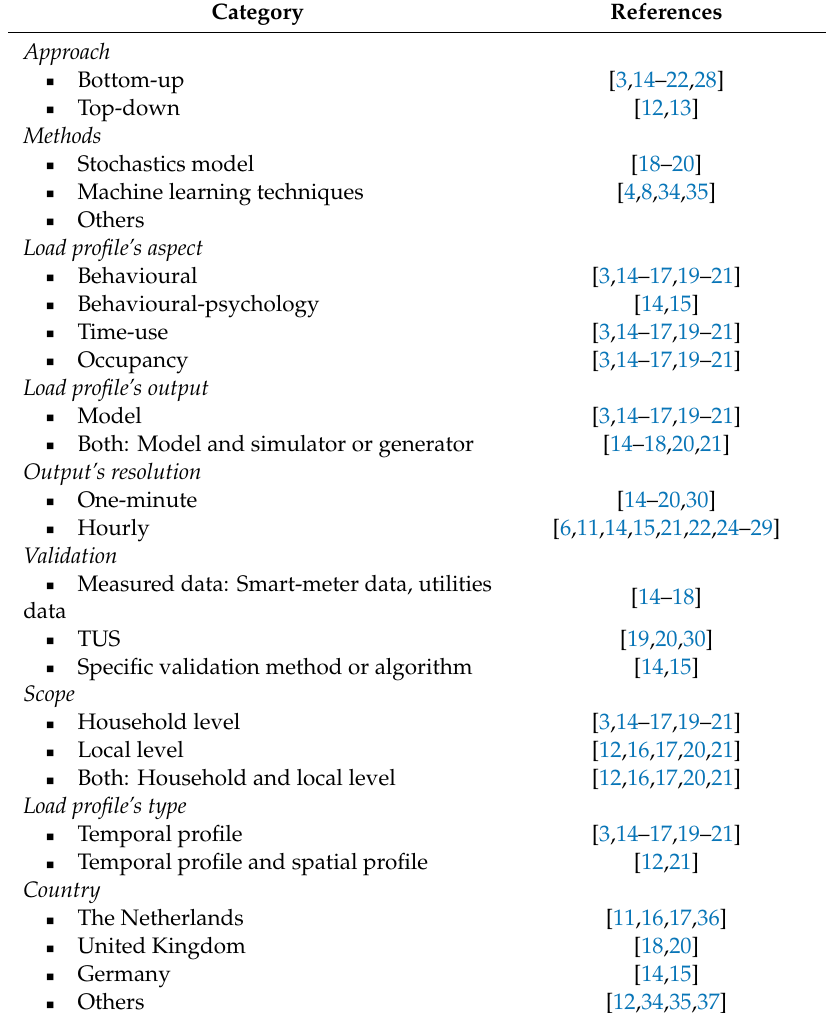
Table 1. Overview of the detail load profile modelling methods based on the discussion provided in the related works’.